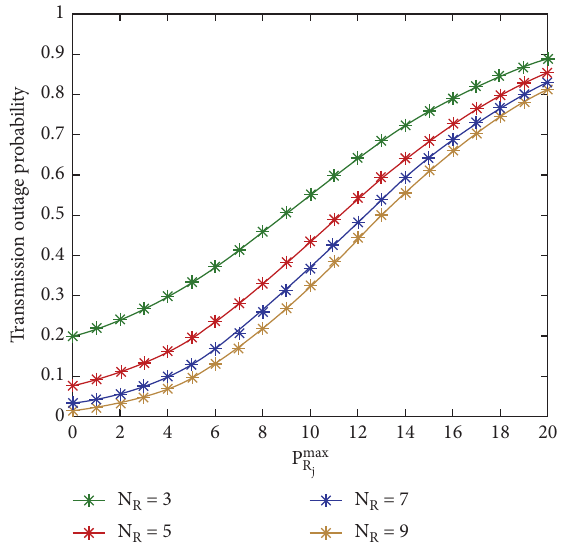
A with different